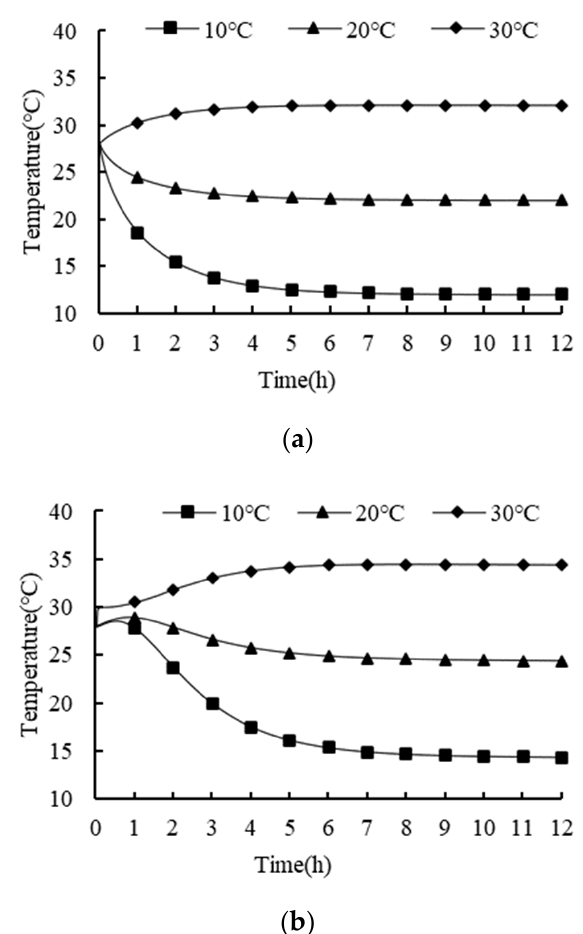
Figure 11. Temperature variations of fresh tea leaves with different ambient temperatures: ( a ) average temperature; and ( b ) maximum temperature.